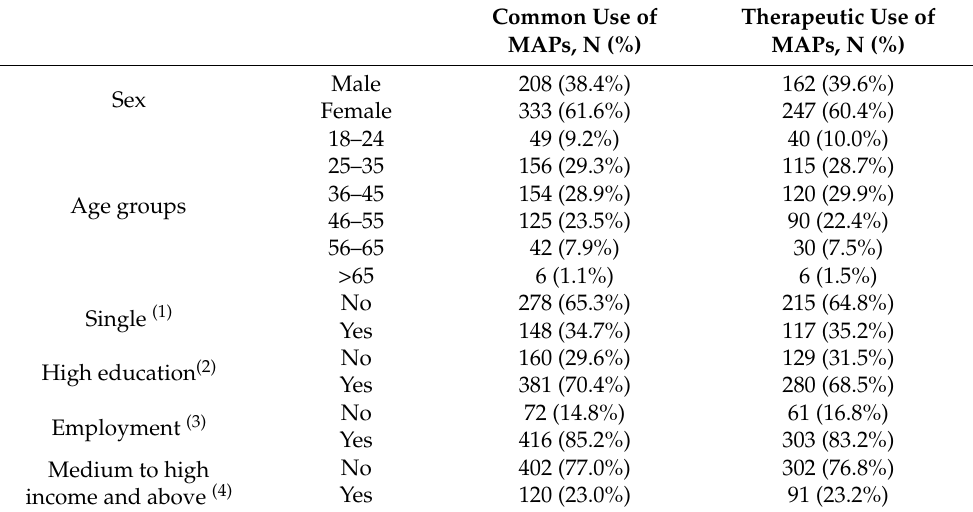
Table 2. Population demographics of positive